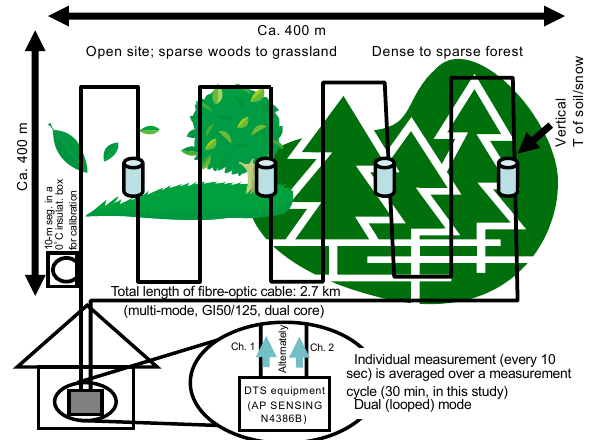
Figure 3. Schematic illustrations of instrument layout and experi- mental